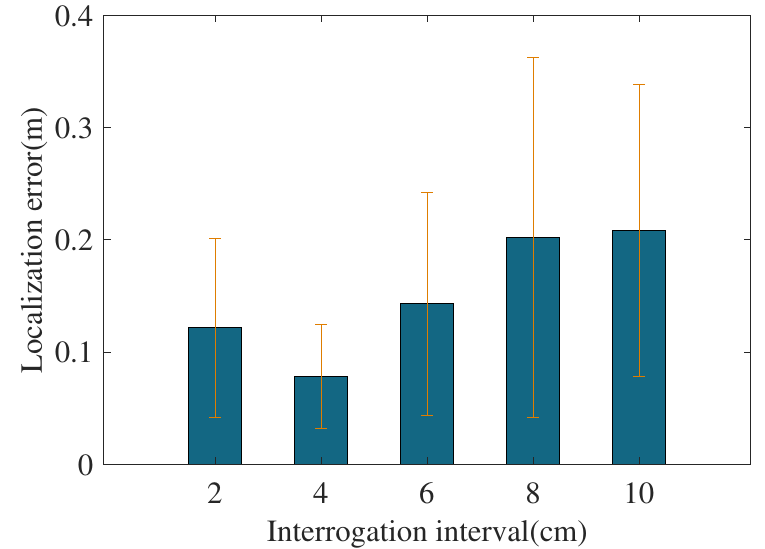
Figure 8. Interrogation interval